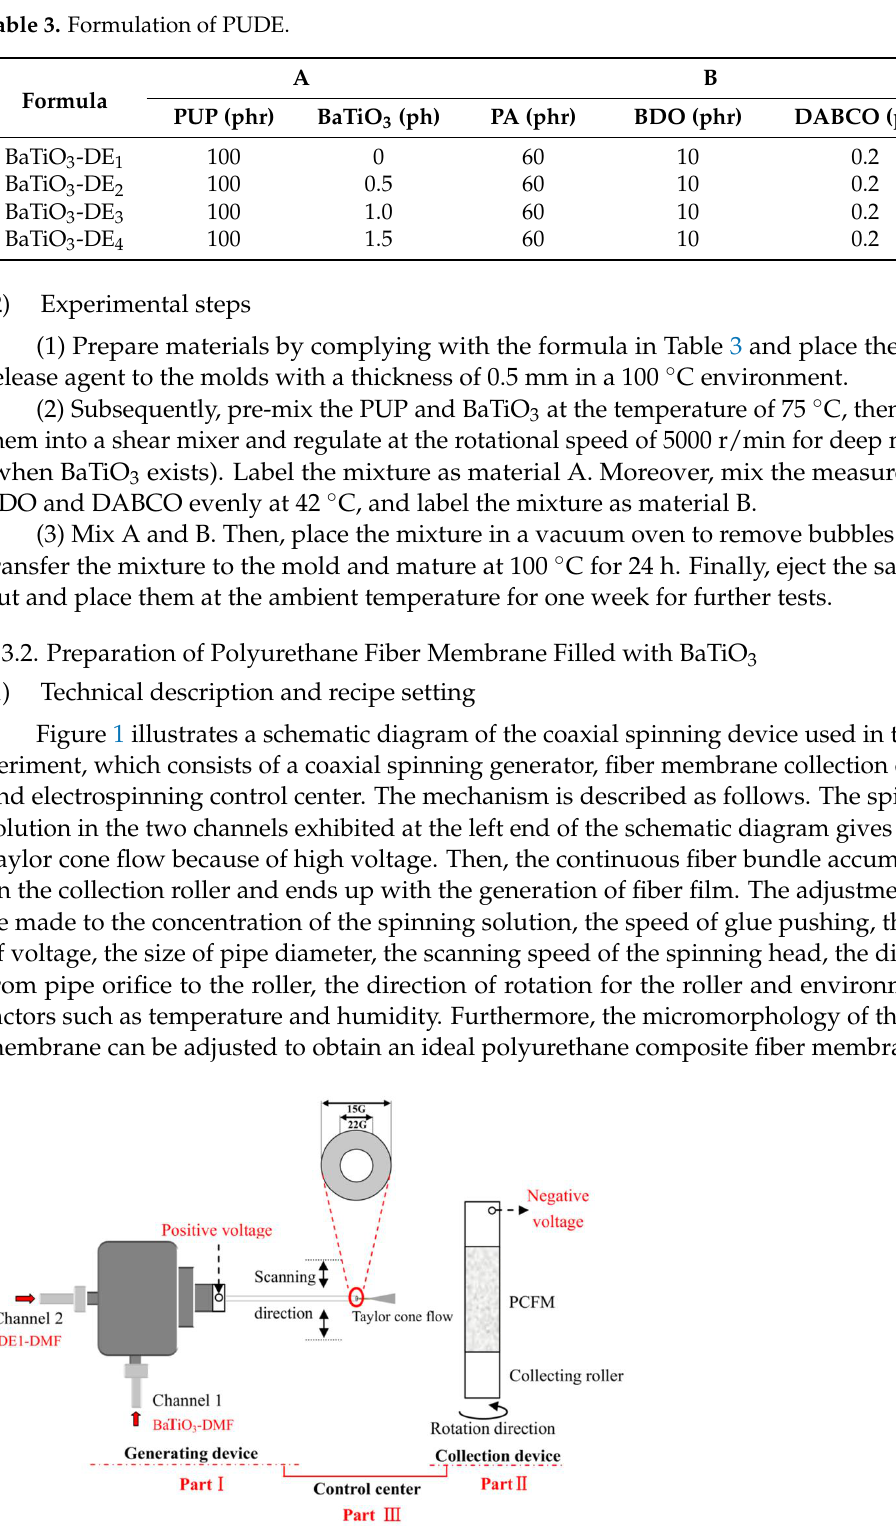
Figure 1. Schematic diagram of coaxial electrospinning technology.